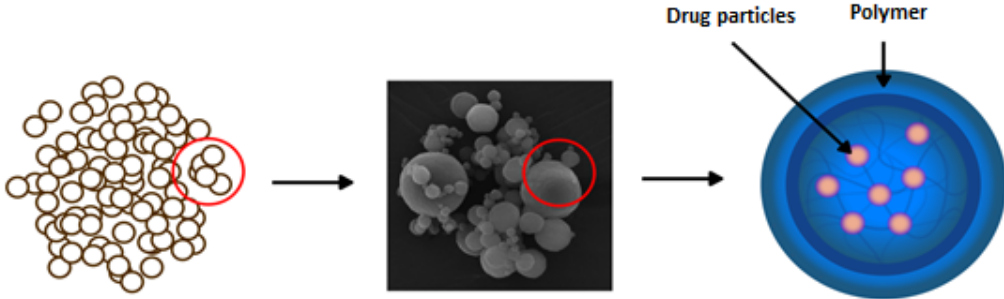
Figure 4. Drug release modification using spray-dried microparticles.